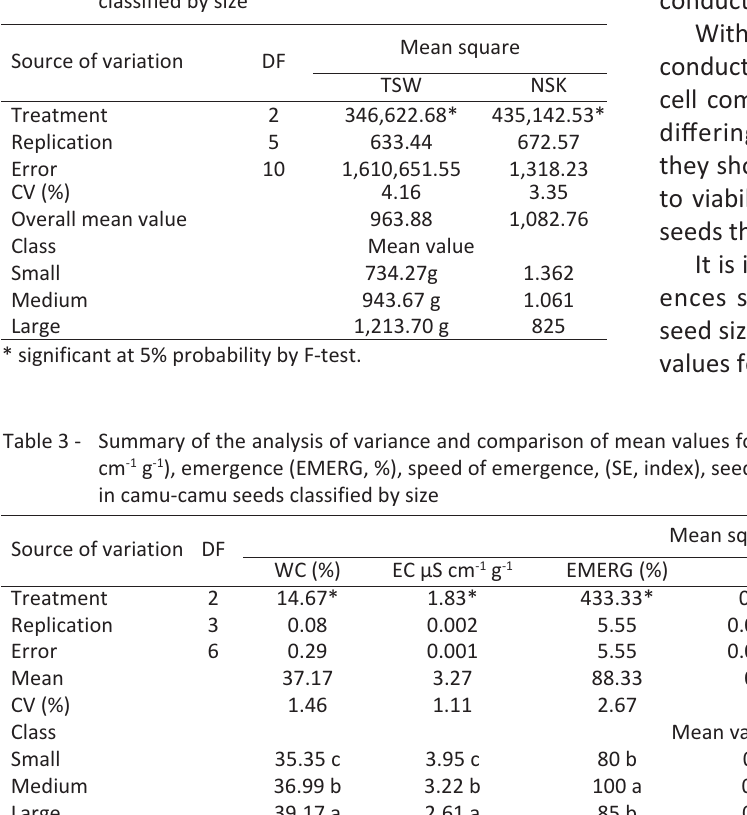
Table 2 - Summary of the analysis of variance and comparison of the mean values for thousand-seed weight (TSW) and number of seeds per kilo (NSK) in camu-camu seeds from native populations in the State of Roraima, classified by size